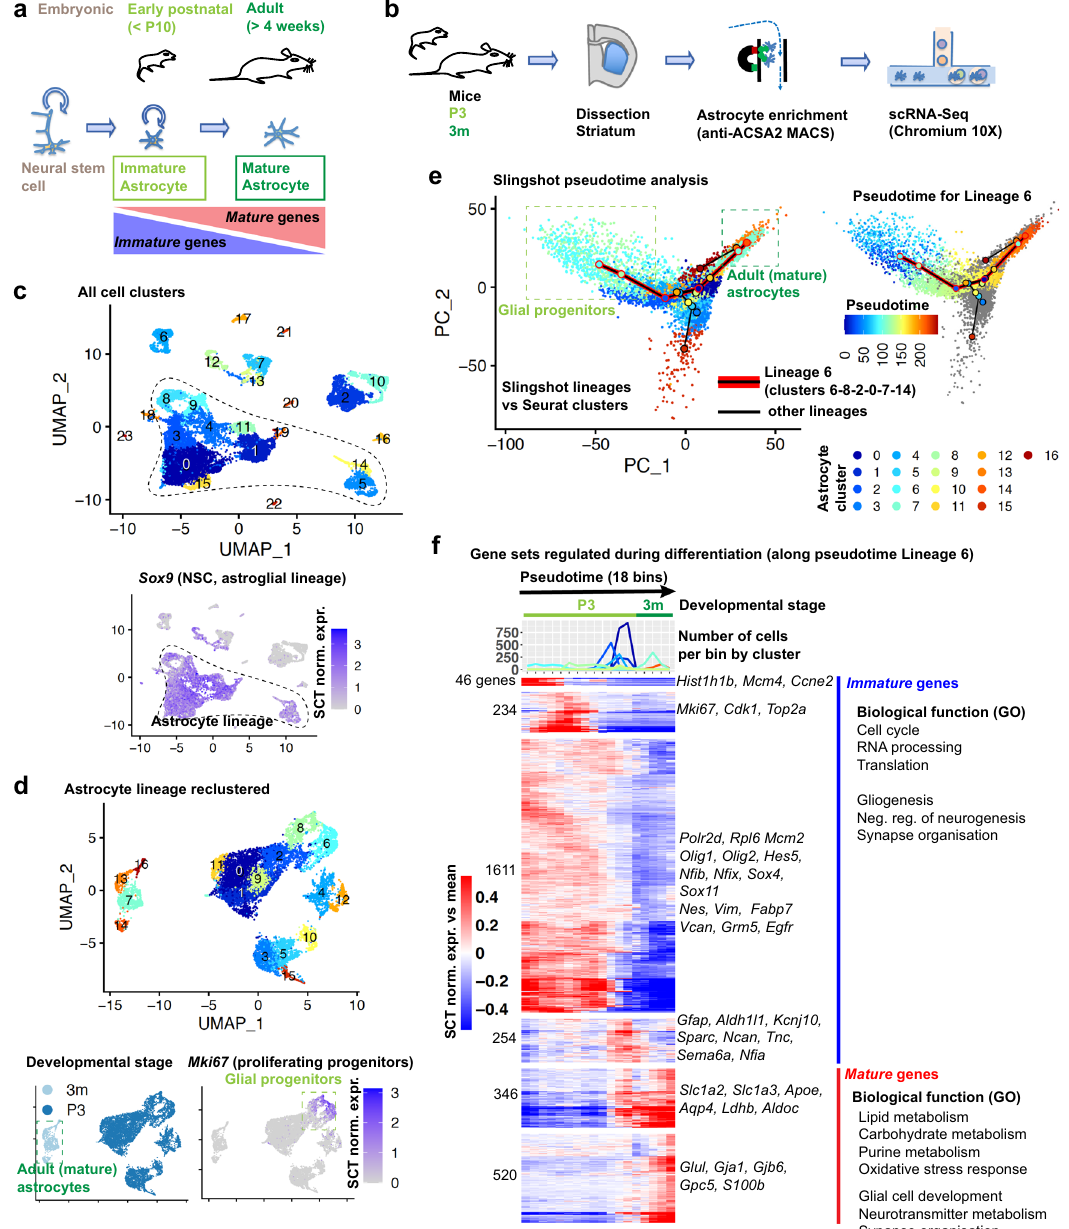
Fig. 1 Astrocyte maturation in vivo proceeds through intermediate stages. a Current model of astrocyte differentiation in mice: neural stem cells generate immature astrocytes that proliferate until around postnatal day 10 (P10) and become fully mature astrocytes by 4 weeks of age. b Approach for single-cell RNA-Seq analysis of striatal astrocyte maturation: immature astrocytes from the striatum of postnatal day 3 (P3) mice and mature astrocytes from the striatum of 3-months-old (3m) mice are enriched by magnetic bead assisted cell sorting (MACS) for the astrocyte-speci fi c ACSA2 antigen, followed by single-cell RNA sequencing (scRNA-Seq). c Uniform Manifold Approximation and Projection (UMAP) dimension reduction plots of combined single-cell transcriptomes from postnatal and adult striatum. Expression of Sox9 is projected on the UMAP plot in the lower graph. d UMAP plot of Sox9 + cells highlighted in ( c ) and reclustered. The lower graphs show cells ’ origin by developmental stage and expression of MKi67 projected on UMAP plot. e Pseudotime analyis of clusters in ( d ) shown projected on a principle component analysis (PCA) plot. Left: cluster assignment and the lineage relationships identi fi ed by Slingshot (starting with the proliferating progenitor cluster 6). Right: pseudotime progression of cells included in the pseudotime trajectory connecting the progenitor cluster 6 with putative mature adult astrocyte clusters 7 and 14 (most different/distant along principle component 1 (PC1)), via the early postnatal clusters 8, 2 and 0 (Lineage 6). f Temporally-expressed genes along the pseudotime trajectory shown in ( e ). The heatmaps show the mean relative expression of each gene in all cells in each pseudotime bin (number of cells from each cluster shown above). Genes were ordered by hierarchical clustering and grouped into gene sets with similar expression patterns. Example genes and potential biological functions based on gene ontology (GO) analysis are shown. 3011 temporally expressed genes were detected with tradeSeq by comparing the 5894 cells assigned to the main pseudotime trajectory (Lineage 6) from ( e ). Gene expression was normalized using the Seurat SCTtransform algorithm (SCT norm. expr.). See also Supplementary Fig. 1, Supplementary Data